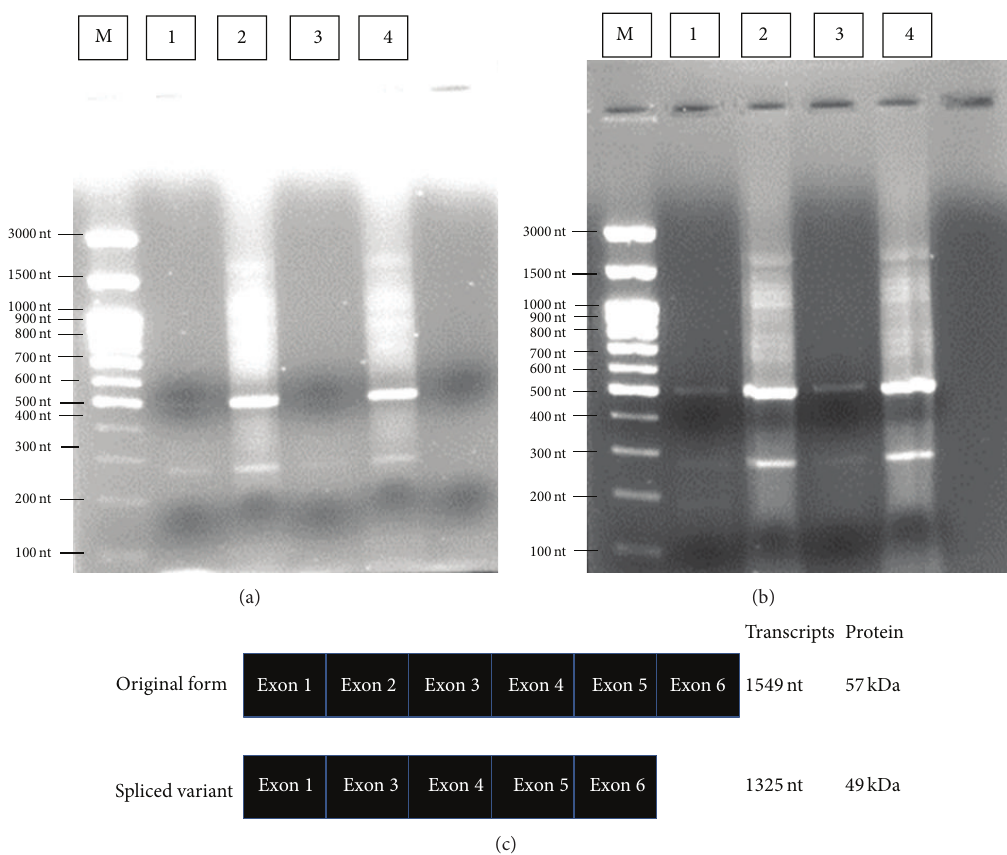
Figure 2: Expression of full-length CYP26B1 (57 kDa) and the CYP26B1 splice variant (49 kDa) in HGF-1 and Ca9-22 cell lines. CYP26B1 and the CYP26B1 splice variant were examined using RT-PCR. (a) Expression of the CYP26B1 gene in nontreated HGF-1 cells. (b) Expression of the CYP26B1 gene in nontreated Ca9-22 cells. (c) Full-length CYP26B1 and the splice variant. M: marker; lane 1: template 2 𝜇 g; lane 2: template 20 𝜇 g; lane 3: template 2 𝜇 g; lane 4: template 20 𝜇